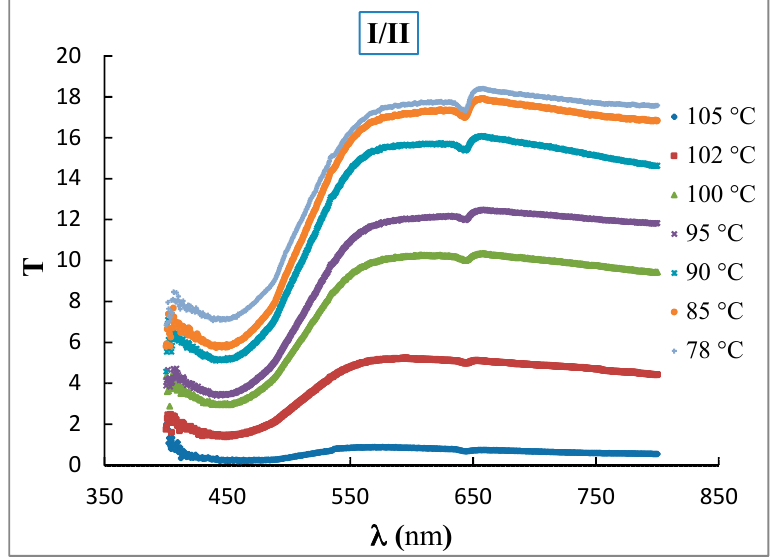
Figure 12. Optical set-up of the modified spectrophotometer (MS) technique for measuring the transmittance and phase transition of LC samples, with diffraction grating (D); rotating disk (R); mirror (M); beam splitter (B); two polarizers (P 1 and P 2 ); and the sample (S) inside electric oven.